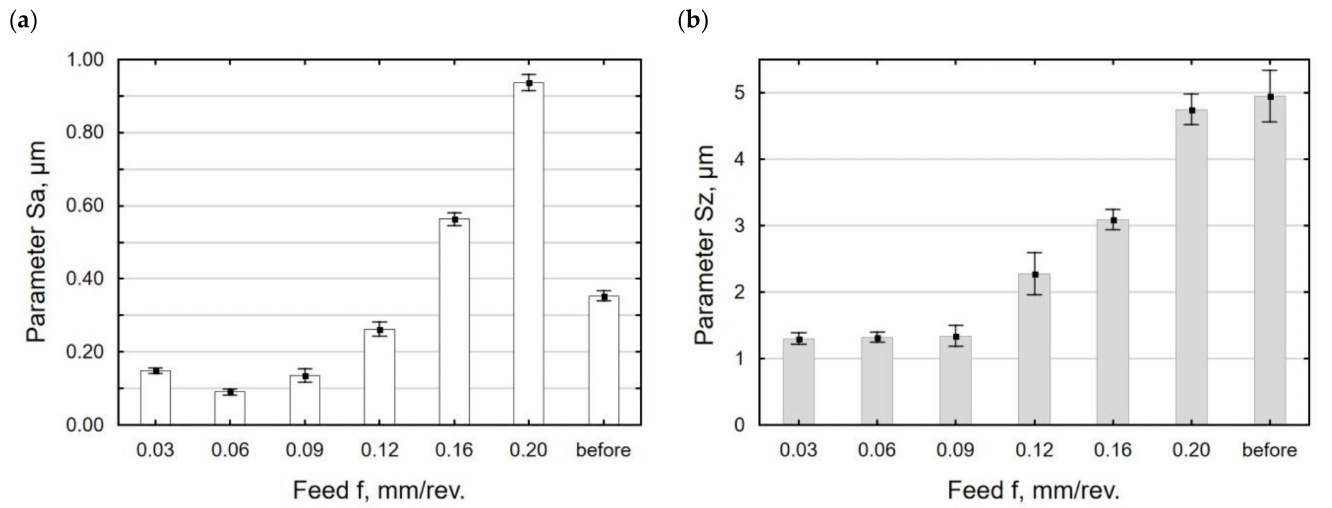
Figure 7. Feed versus surface roughness parameters Sa ( a ) and Sz ( b ) ( F = const. = 230 N, v n = 35 m/min, i =